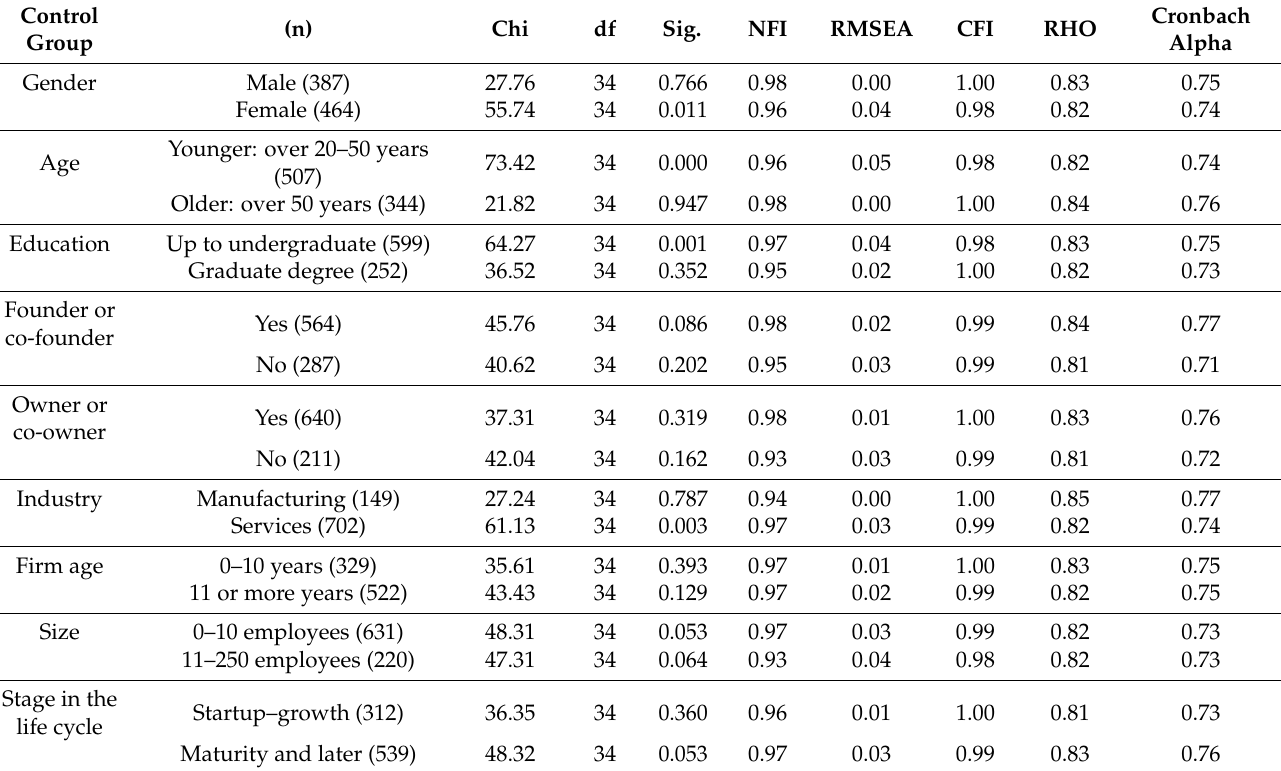
Table 6. Structural equation modeling results—controls (goodness-of-fit and